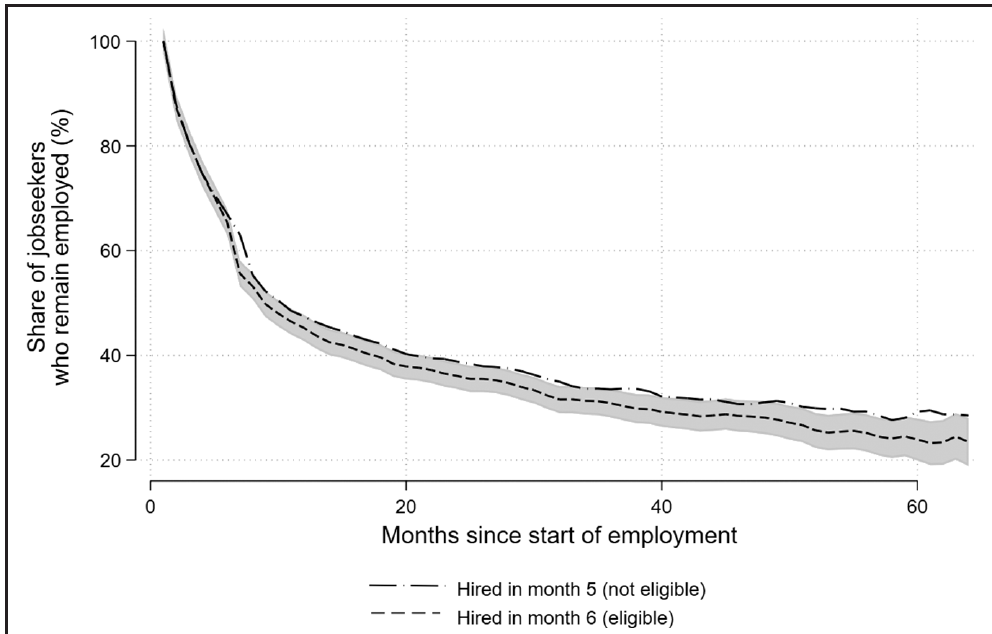
Figure 2 Employment stability: share of individuals aged 45–48 years hired in Month 5 (not eligible for the subsidy) vs. in Month 6 (eligible for the subsidy) employed for 1–65 consecutive months after being